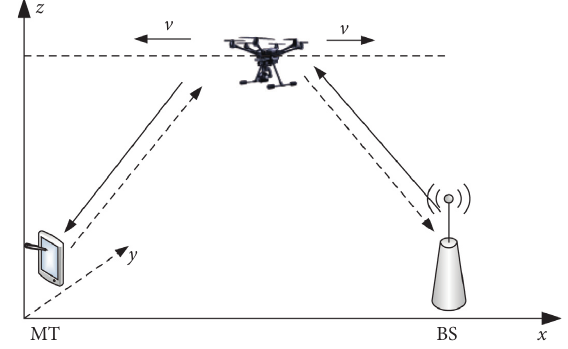
Figure 2: UAV-assisted MEC system